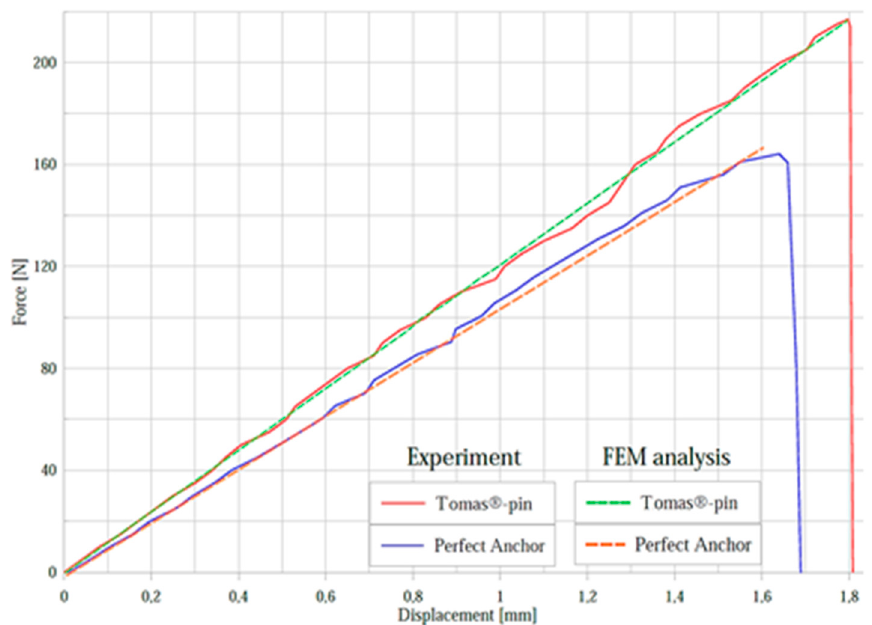
Figure 10. Comparison of pull-out diagram obtained with FEM analysis with the experimental diagram for Tomas ® -pin and Perfect Anchor mini-implants.